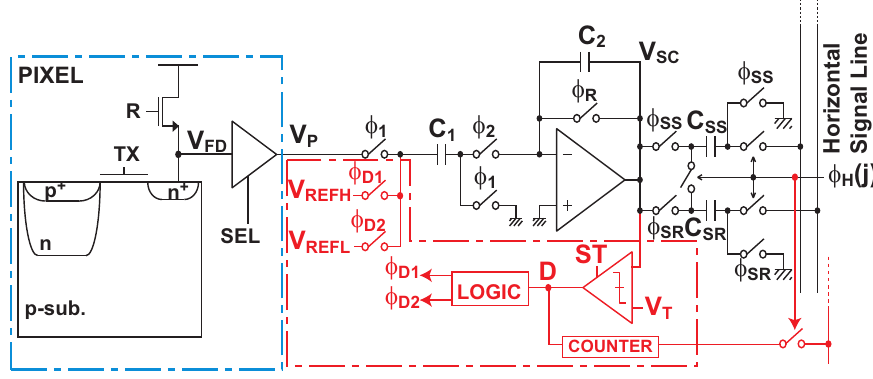
Figure 3. Schematic and Timing Diagram CMS circuits using the Folding Integration Technique.